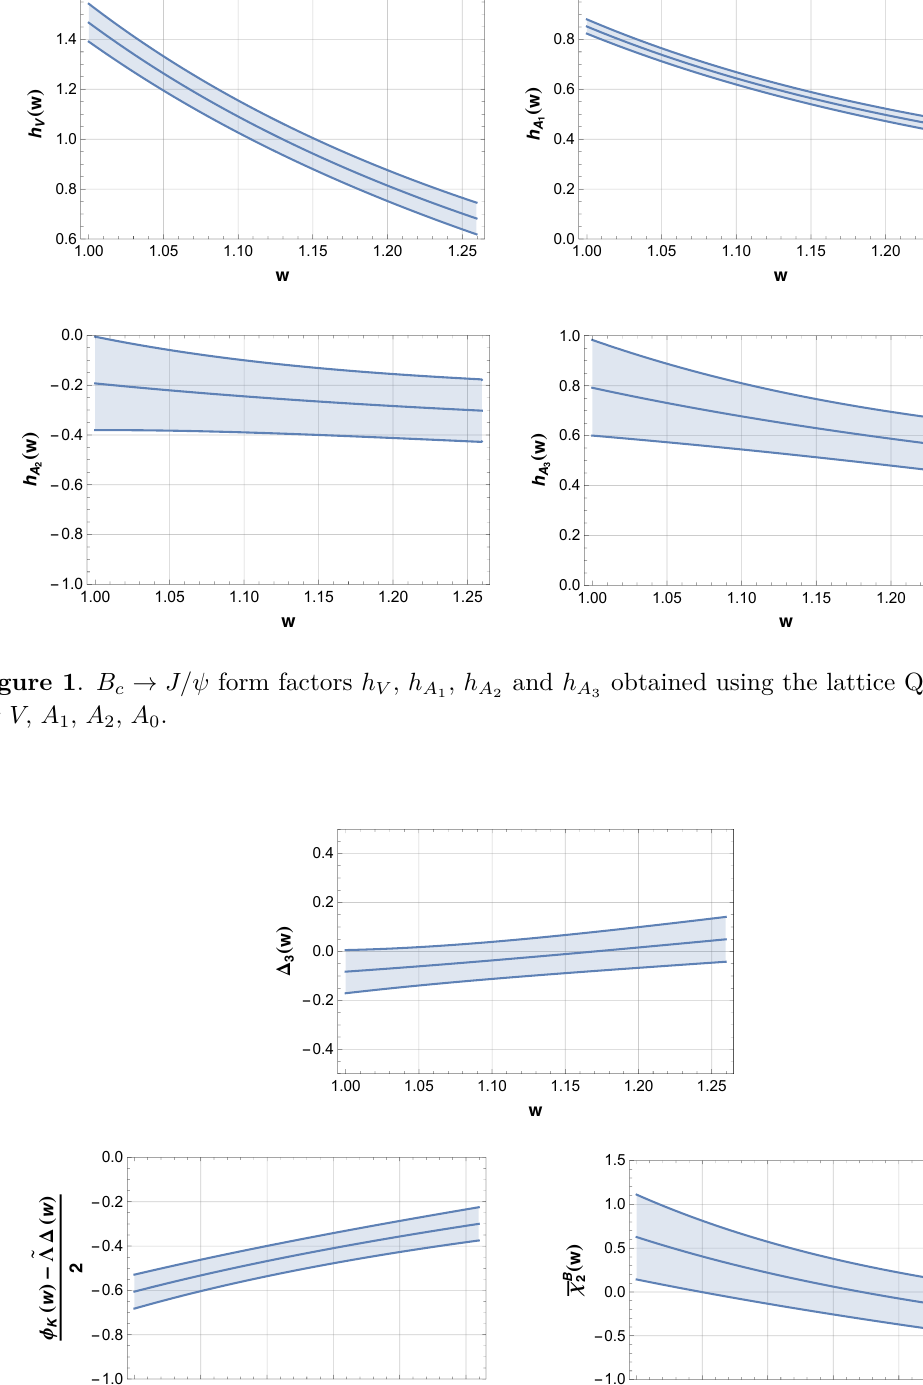
Figure 2 . Functions in eqs. (5.7), (5.8) and (5.9) extrapolated to the full kinematical